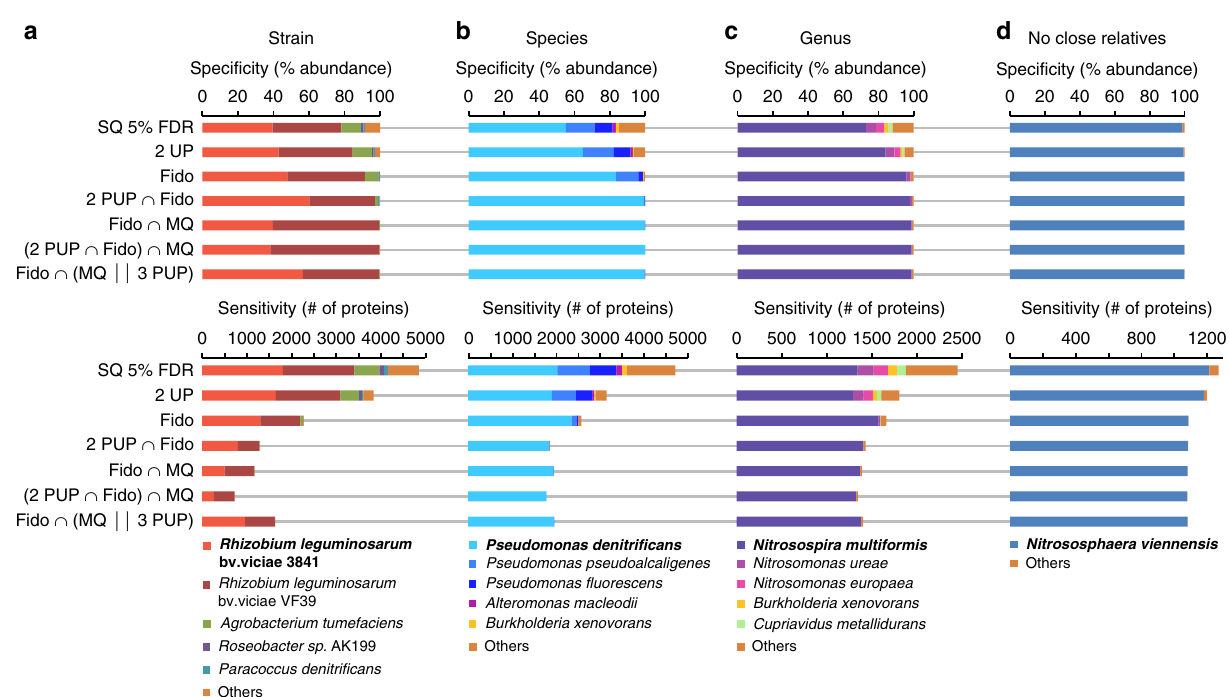
Fig. 2 Speci fi city and sensitivity of protein identi fi cation with different protein inference strategies. The proteomics data for four pure cultures ( a R. leg . bv. viciae 3841, b P. denitri fi cans , c N. multiformis , d N. viennensis ) were analyzed in separate runs. For all cultures, proteins were identi fi ed with the same simulated metagenomic database containing 30 different species, which included other organisms related at the strain ( a ), species ( b ), or genus level ( c ). For d , no closely related organisms were included. Upper panels show speci fi city (% abundance of proteins attributed to each organism) and lower panels sensitivity (# of proteins identi fi ed). More stringent identi fi cation strategies improve speci fi city at the expense of sensitivity. Protein inference strategies: SQ 5% FDR; SEQUEST search fi ltered for 5% false discovery rate (FDR) using standard Target-Decoy strategy (implemented as Protein FDR Validator Node in Proteome Discoverer). 2 UP; same as previous, but only the subset of proteins identi fi ed with at least two unique peptides (UP). Fido; SEQUEST- Fido results fi ltered at 5% FDR based on protein q -value. 2 PUP ∩ Fido; same as previous, but only the subset of proteins identi fi ed with at least two protein unique peptides (PUP). Fido ∩ MQ; Only proteins identi fi ed both by Sequest-Fido (FDR 5%) and MaxQuant (1% protein FDR, at least 2 razor + unique peptides). (2 PUP ∩ SQ Fido) ∩ MQ; Same as previous, but for SEQUEST-Fido only the subset of proteins identi fi ed with at least two protein unique peptides. Fido ∩ (MQ || 3 PUP); Only proteins that were identi fi ed both by SEQUEST-Fido and MaxQuant. Additionally, SEQUEST-Fido identi fi ed proteins were retained even if they were not identi fi ed by MaxQuant if they had at least three protein unique